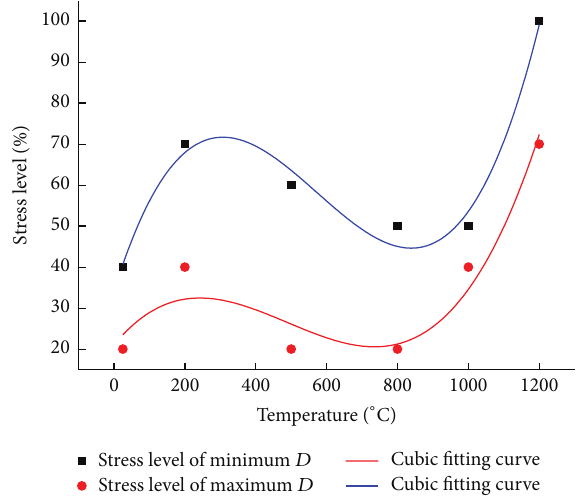
Figure 12: The stress levels corresponding to maximum and mini- mum 𝐷 values at different